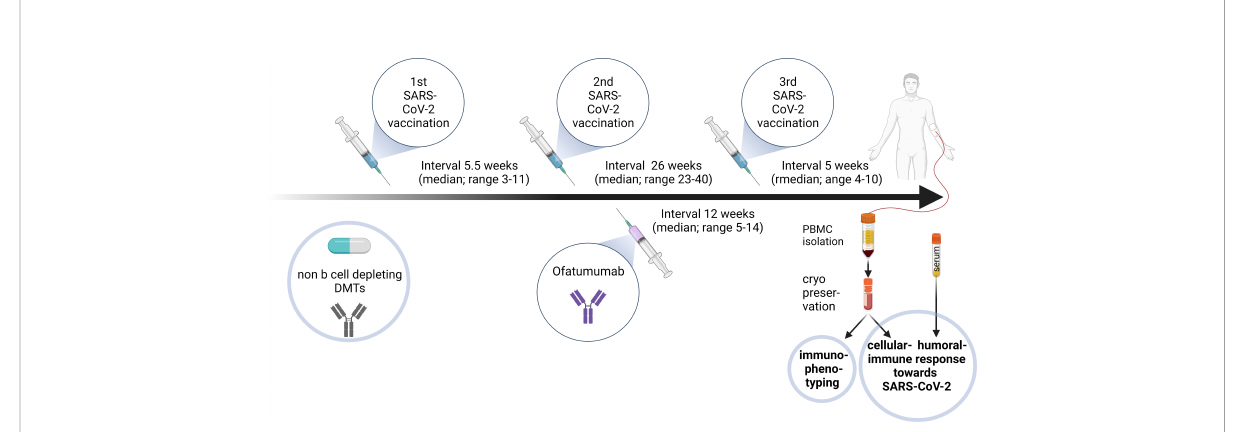
FIGURE 1 Diagram outlining the study design for ofatumumab treated MS patients. 9/10 relapsing remitting multiple sclerosis (RRMS) patients were under different disease modifying therapies (DMTs) during the fi rst and second SARS-CoV-2 vaccinations, conducted in a median 5.5-week interval. After the second vaccination ofatumumab was initiated before the third vaccination (median 26 weeks after second vaccination and median 12 weeks after fi rst ofatumumab administration). Blood was sampled 5 weeks (median) after the booster vaccination. Peripheral blood mononuclear cells (PBMCs) and serum were isolated and cryopreserved. PBMCs were used for immunophenotyping. Humoral and cellular immune response towards SARS-CoV-2 restimulation were assessed in different assays. Created with